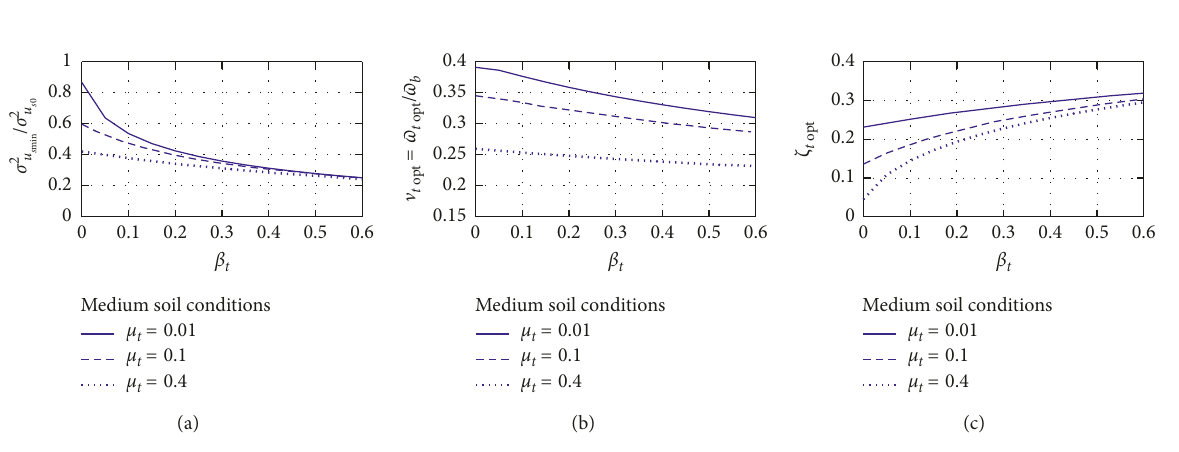
Figure 6: Optimal TMDI tuning for firm soil conditions: (a) minimum OF achieved, normalized with respect to the case without TMDI; (b) optimal frequency ratio; (c) optimal damping ratio.